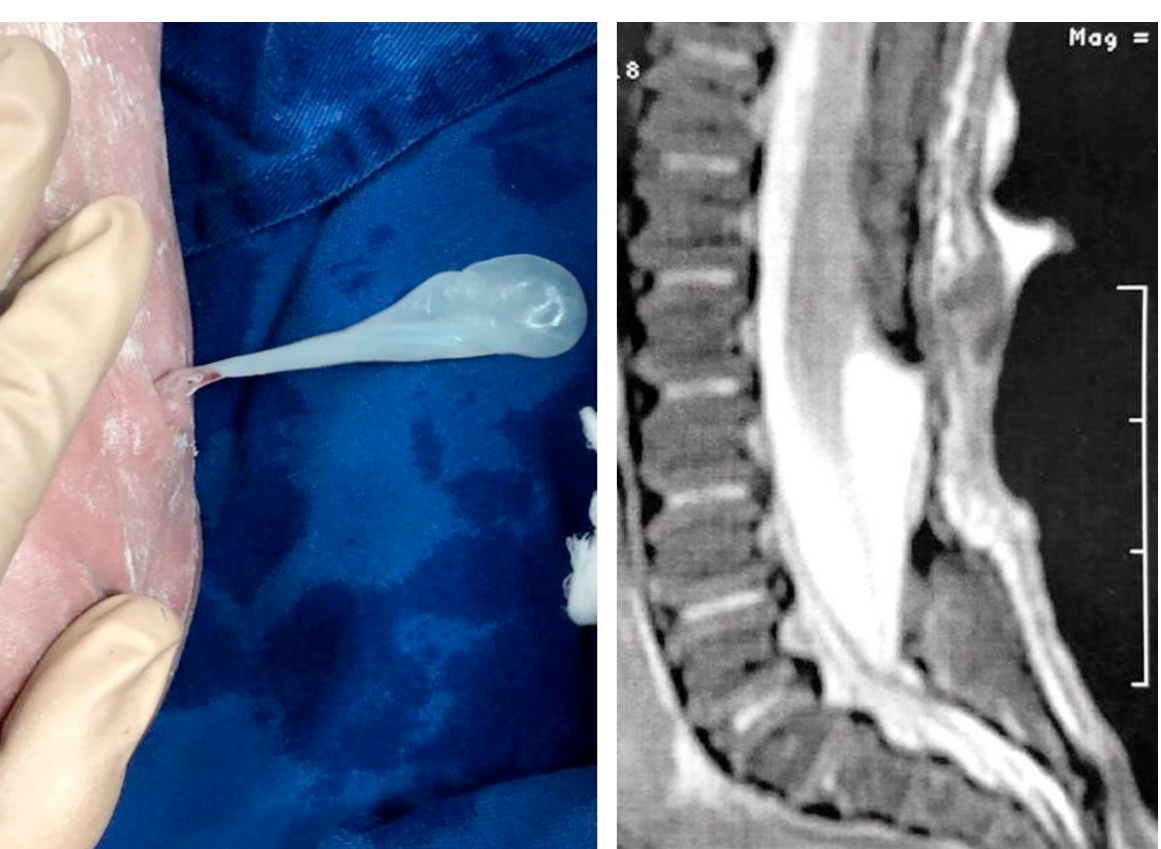
Figure 1 -Image of an amniotic band attached to lumbar human tail at born and a Lumbosacral midsagittal Magnetic resonance weight in T2 showing a Lumbar dysraphism.